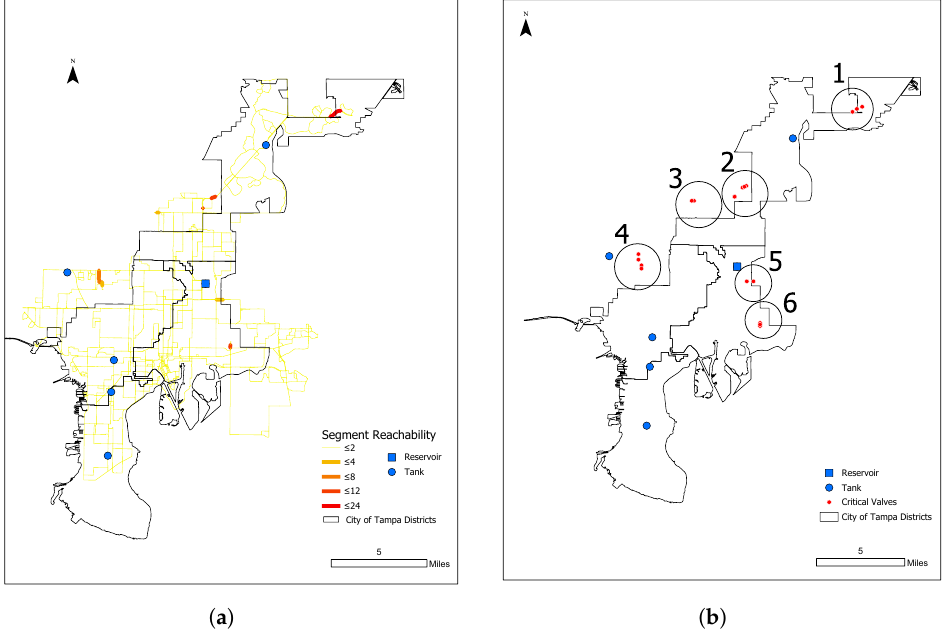
Figure 3. Segment reachability values and the subsequently identified critical valves. ( a ) Map of segment reachability values. ( b ) Map of critical